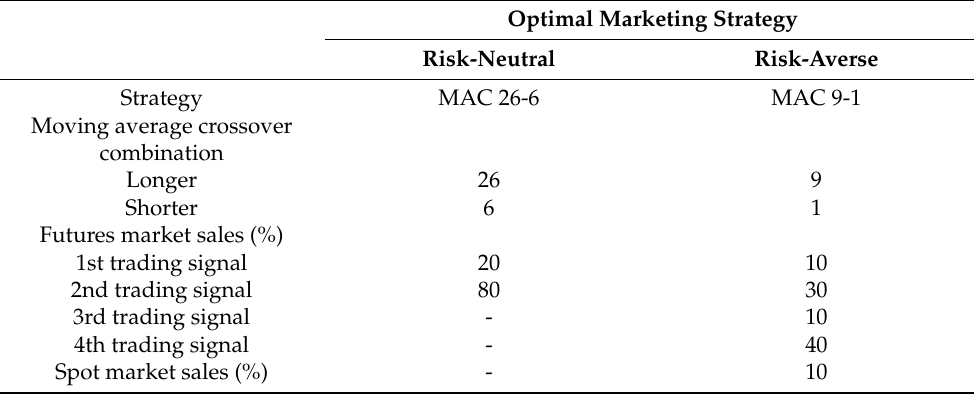
Table 1. Optimal moving average crossover (MAC) combinations and hedge ratios for risk-neutral and risk-averse producers’ marketing